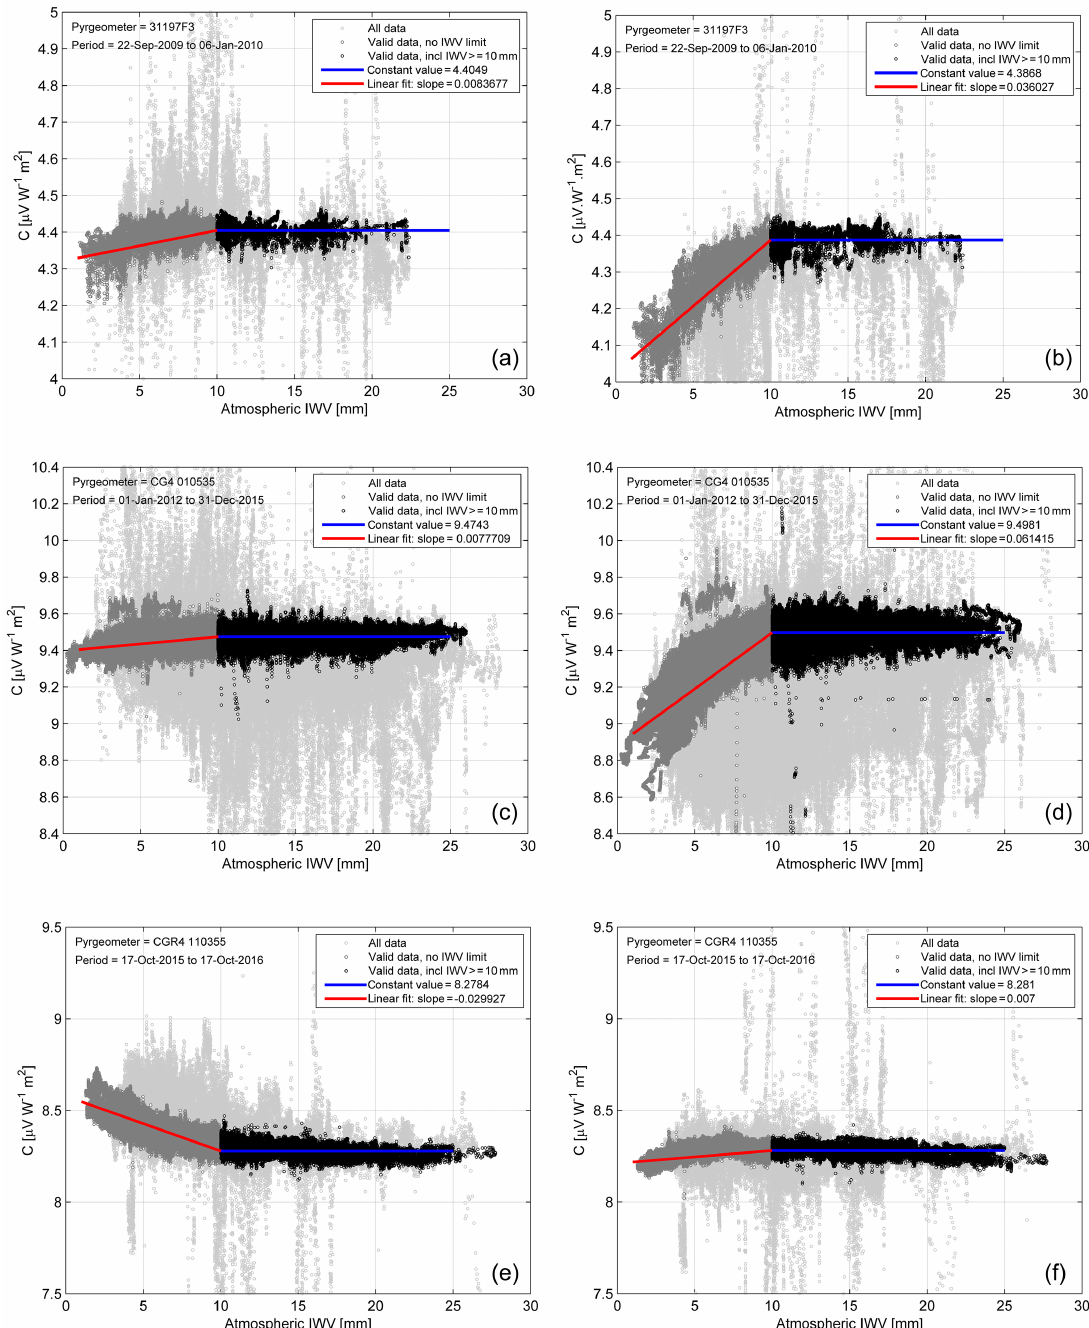
Figure 1. Graphs of sensitivity ( C ) as a function of IWV during extended calibration measurements at PMOD/WRC. Rows contain graphs representative of the three groups discussed in the text: (a–b) Eppley PIR group (PIR-31197), (c–d) pre-2003 K&Z CG4 group (CG4-010535, i.e. WISG-4) and (e–f) post-2003 K&Z CG4/CGR4 group (CGR4-110355). Pyrgeometers in the left column are calibrated with respect to the WISG IPASRC , and those on the right with respect to CG4-030669 IPASRC . Note that each pair of graphs has the same y -axis